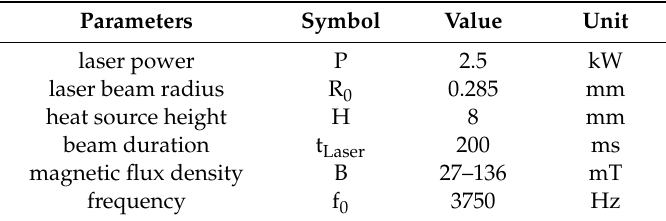
Table 3. The used process parameters of the two-dimensional